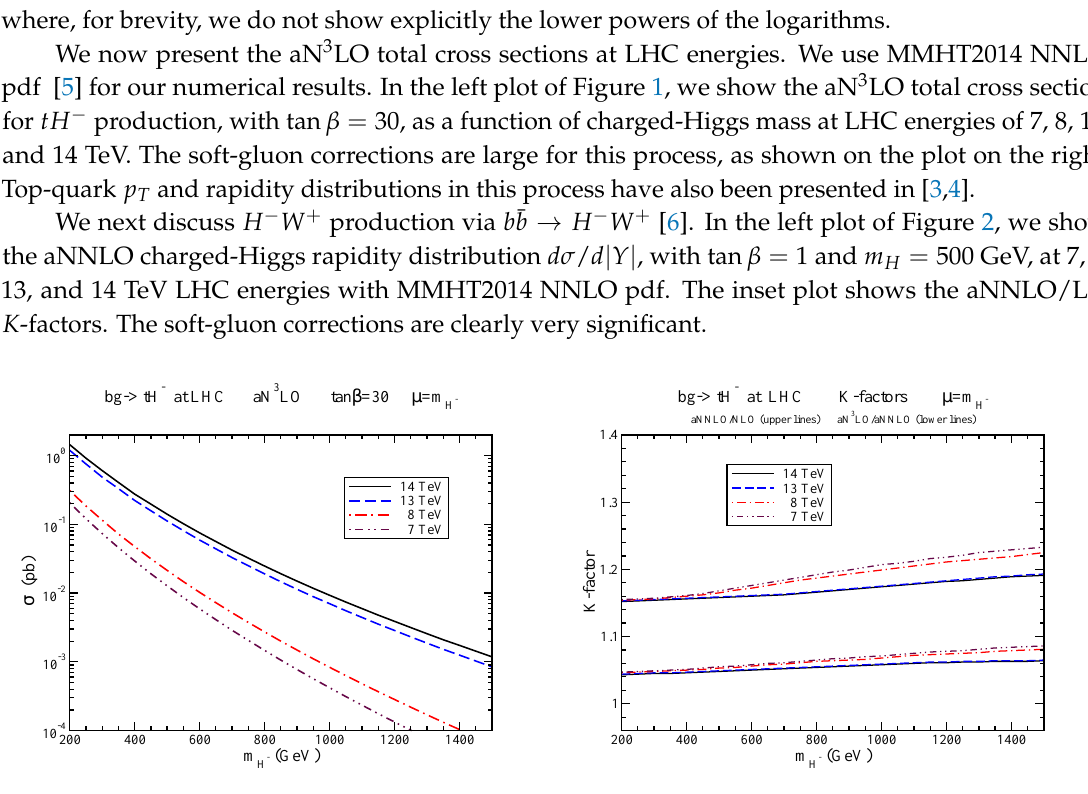
Figure 1. ( Left ) aN 3 LO total cross sections for tH − production; ( Right ) K -factors for tH −